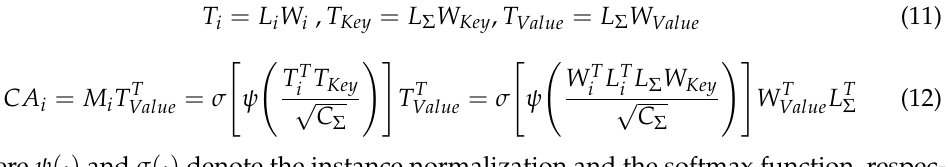
Figure 3. Multi-Head Cross-Fusion Transformer (MCT). Embedding Multi-Scale Features. The embedding of multi-scale features starts by labeling the features with the I i of the multi-scale feature of the given osteosarcoma MRI image, and reshaping the 2D patch of the flat feature sequence so that the patch size is P , P /2, P /4, and P /8. In this process, the channel size remains the same. We then connect the four layers as keys and values L Σ = Concat ( L 1 , L 2 , L 3 , L 4 ) and feed them into a multi- headed cross-attention module to encode the channels and dependencies to refine the features at the encoder level of each osteosarcoma MRI image using multiscale features. Multi-Crossing Attention. As shown in Figure 4, there are five inputs required for this module. Let T i (cid:101) R C i × d , T Key (cid:101) R C Σ × d , T Value (cid:101) R C Σ × d , and W i (cid:101) R C i × d , W Key (cid:101) R C Σ × d ,